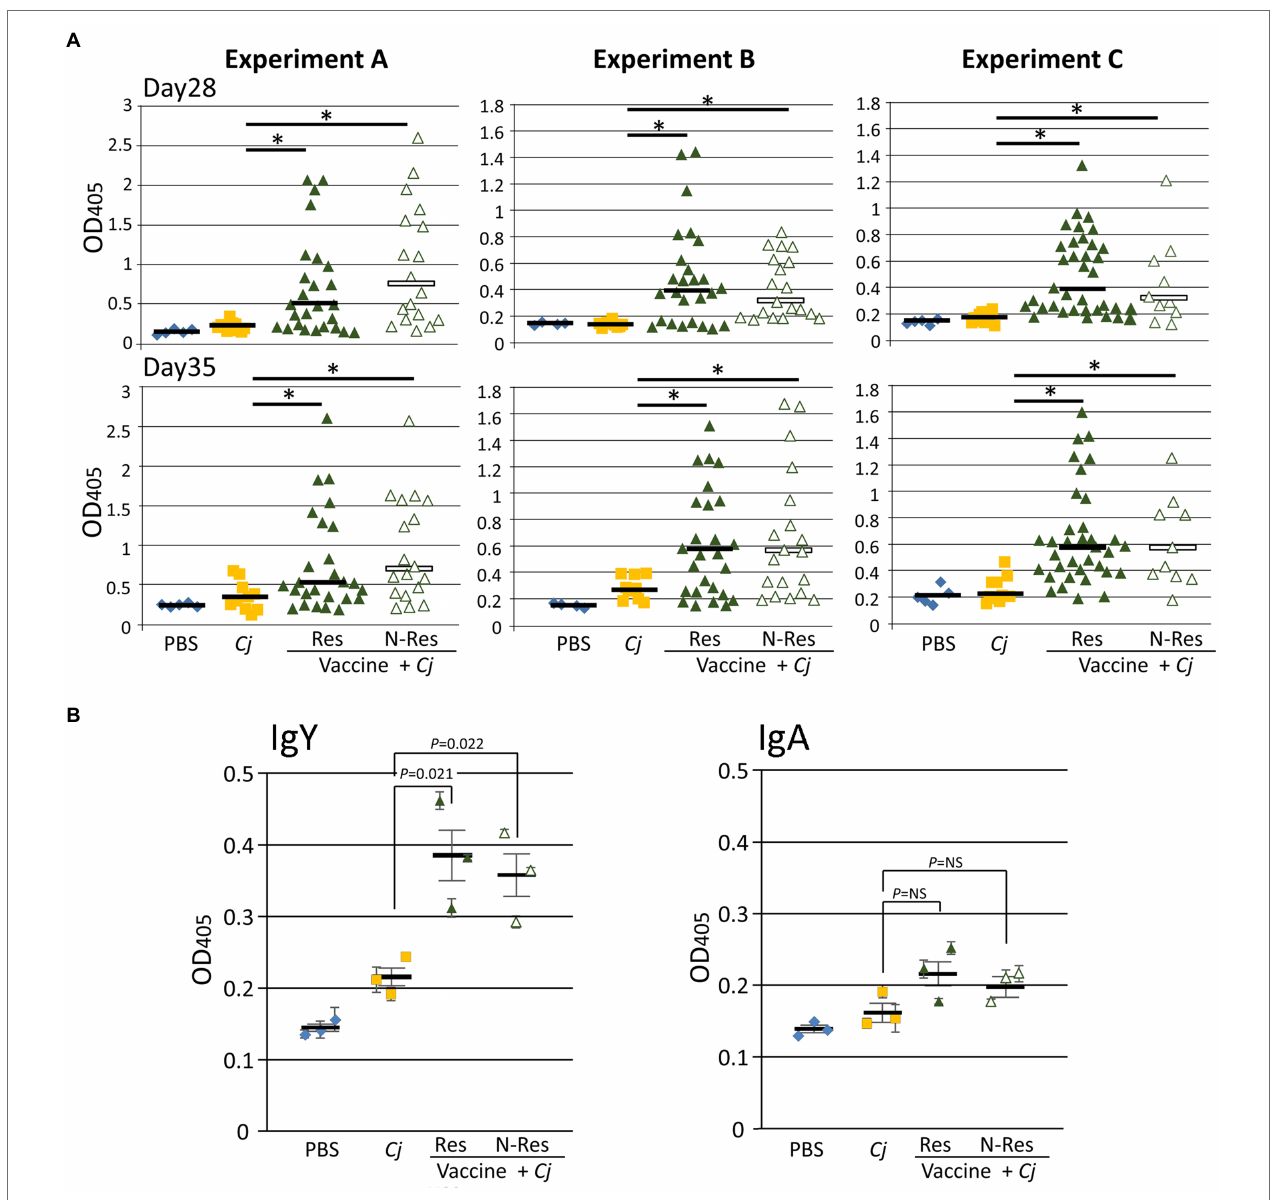
FIGURE 2 | The N-glycan-specific immune responses. (A) ELISA results comparing chicken sera from bleeds taken prior to C. jejuni challenge (day 28) and at day 35. Each point represents the N-glycan-specific antibody response measured at OD 450 for each individual chicken from the indicated group. For the vaccine + Cj groups, responders (Res) and non-responders (N-Res) are shown as individual subgroups; no significant differences between the two subgroups (two-tailed t -test, p > 0.05) were found. No N-glycan-specific antibodies were detected in sera of blood samples taken on day 1. (B) ELISA results comparing N-glycan-specific IgY and IgA levels (as indicated) in individually pooled cecal contents from each group. Each dot in the respective group represents one study (Experiment A, B, or C = biological replicate) with measurements carried out in triplicate and error bars representing the standard error of the mean for each replicate. Bars represent the median for each group/subgroup and error bars in (B) indicate the standard error of the mean (SEM) for the biological replicates. Statistically significant differences (two-tailed t -test, p < 0.05) are either indicated by an asterisk or the value of p is provided for the specific comparison, NS = not significant. PBS, Phosphate-buffered saline; Cj , Campylobacter